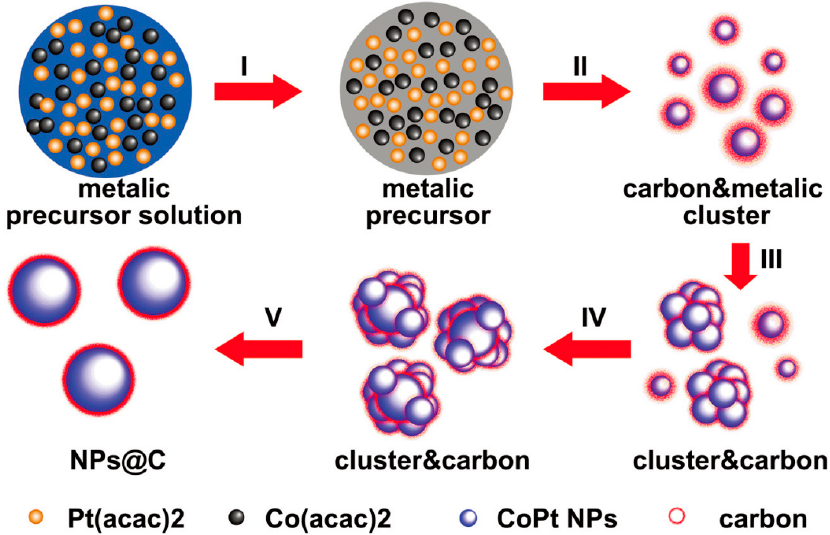
Figure 1. Schematic representation of the formation of L1 0 -CoPt@C nanostructures [17]. Reproduced with permission from [Baoru Bian et al.], [Nanoscale]; published by [Royal Society of Chemistry], 2015.